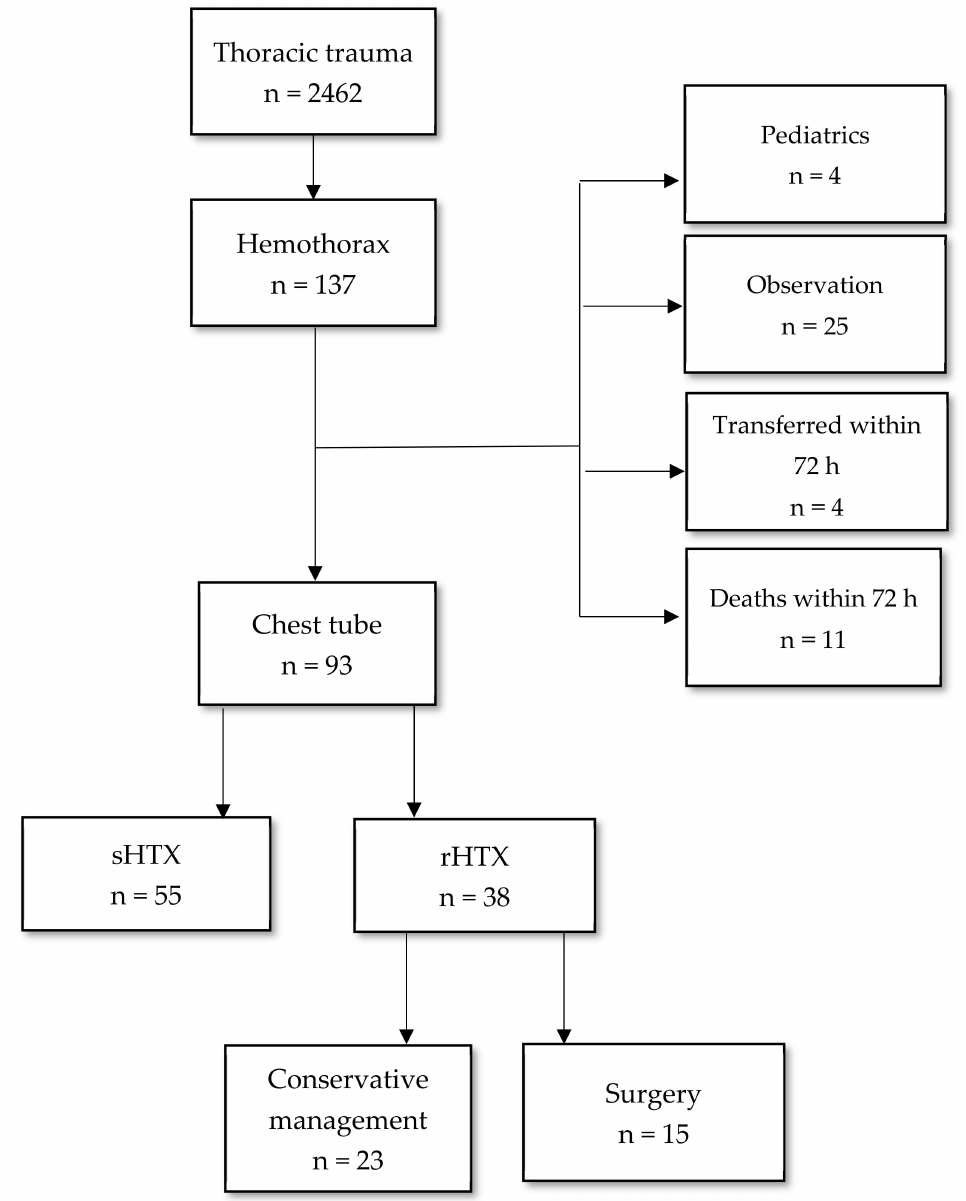
Figure 1. Study flow-chart—sHTX (simple hemothorax); rHTX (retained hemothorax). Population: All adult (>16 years old) trauma patients diagnosed with HTX between January 2011 and December 2020 were enrolled in the study. Patients with HTX were excluded if they were not treated by tube thoracostomy placement or treated only by thoracentesis. Dead or transferred patients within 72 h were also excluded.